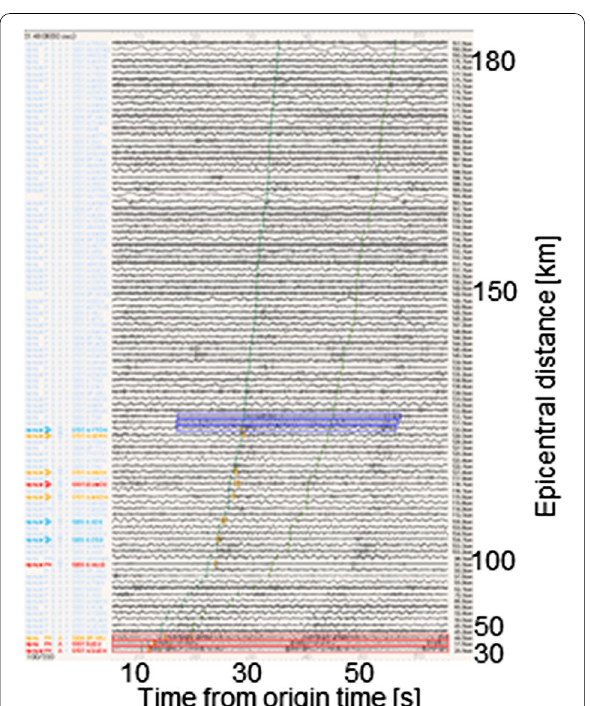
Fig. 5 Hypocenter distribution used for seismic